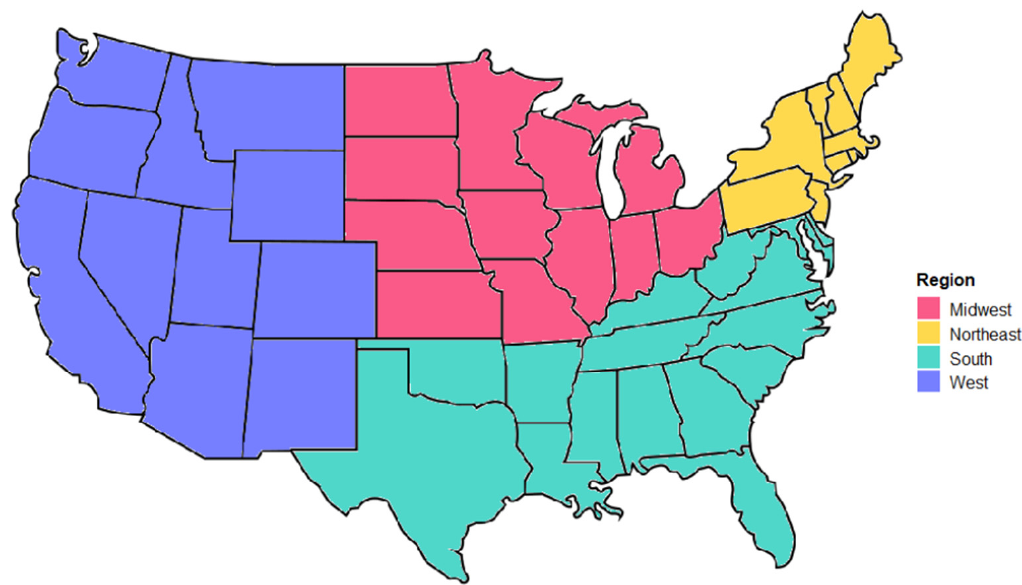
Figure 2. Regions of the United States.